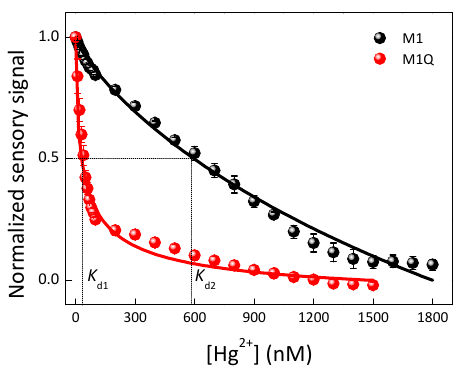
Figure 2. ( a , b ) PL spectra of M1 in CH 3 CN/water (8:2) and M1Q in water with increasing [Hg 2+ ]. ( c , d ) Normalized PL intensity ( I / I 0 ) of M1 and M1Q with changing [Hg 2+ ] ( I / I 0 , where I and I 0 are the PL intensity at λ PL in the presence and absence of Hg 2+ ions). Excitation at 390 nm. Inset: LOD determination. The error bars represent the standard deviation of six independent measurements.